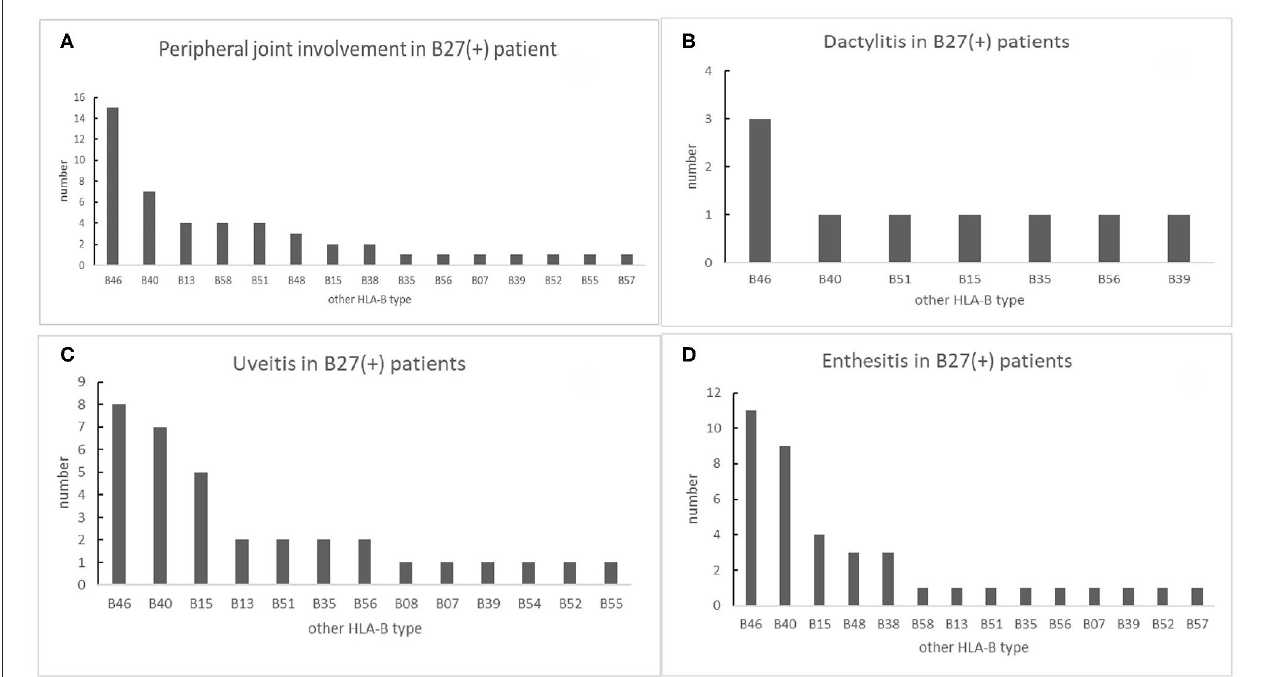
FIGURE 5 | The number of other HLA-B types shown in B27( + ) patients with different peripheral manifestations: (A) number of other HLA-B types shown in B27( + ) patients with peripheral joint involvement, (B) number of other HLA-B types shown in B27( + ) patients with dactylitis, (C) number of other HLA-B types shown in B27( + ) patients with uveitis, and (D) number of other HLA-B types shown in B27( + ) patients with enthesis.